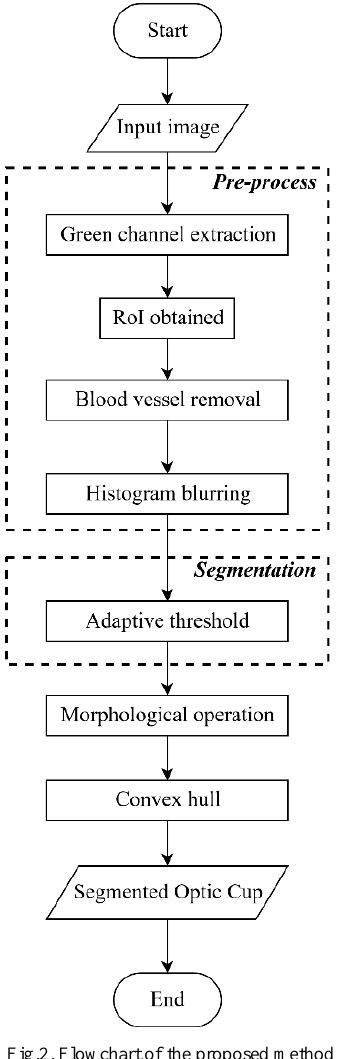
Fig.2. Flowchart of the proposed